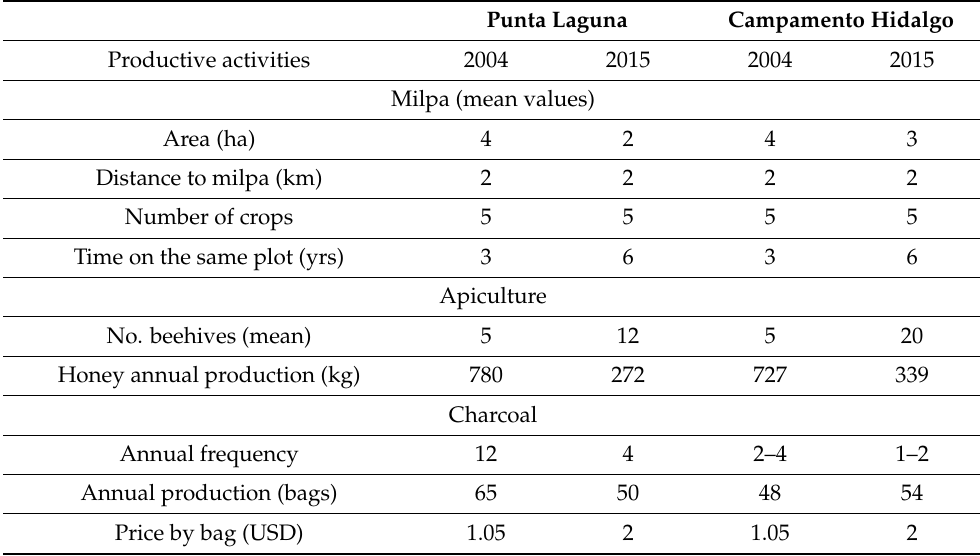
Table 3. Change in production from households inside (PL) and outside the PA (CH), in 2004 and 2015. Punta Laguna Campamento Hidalgo Productive